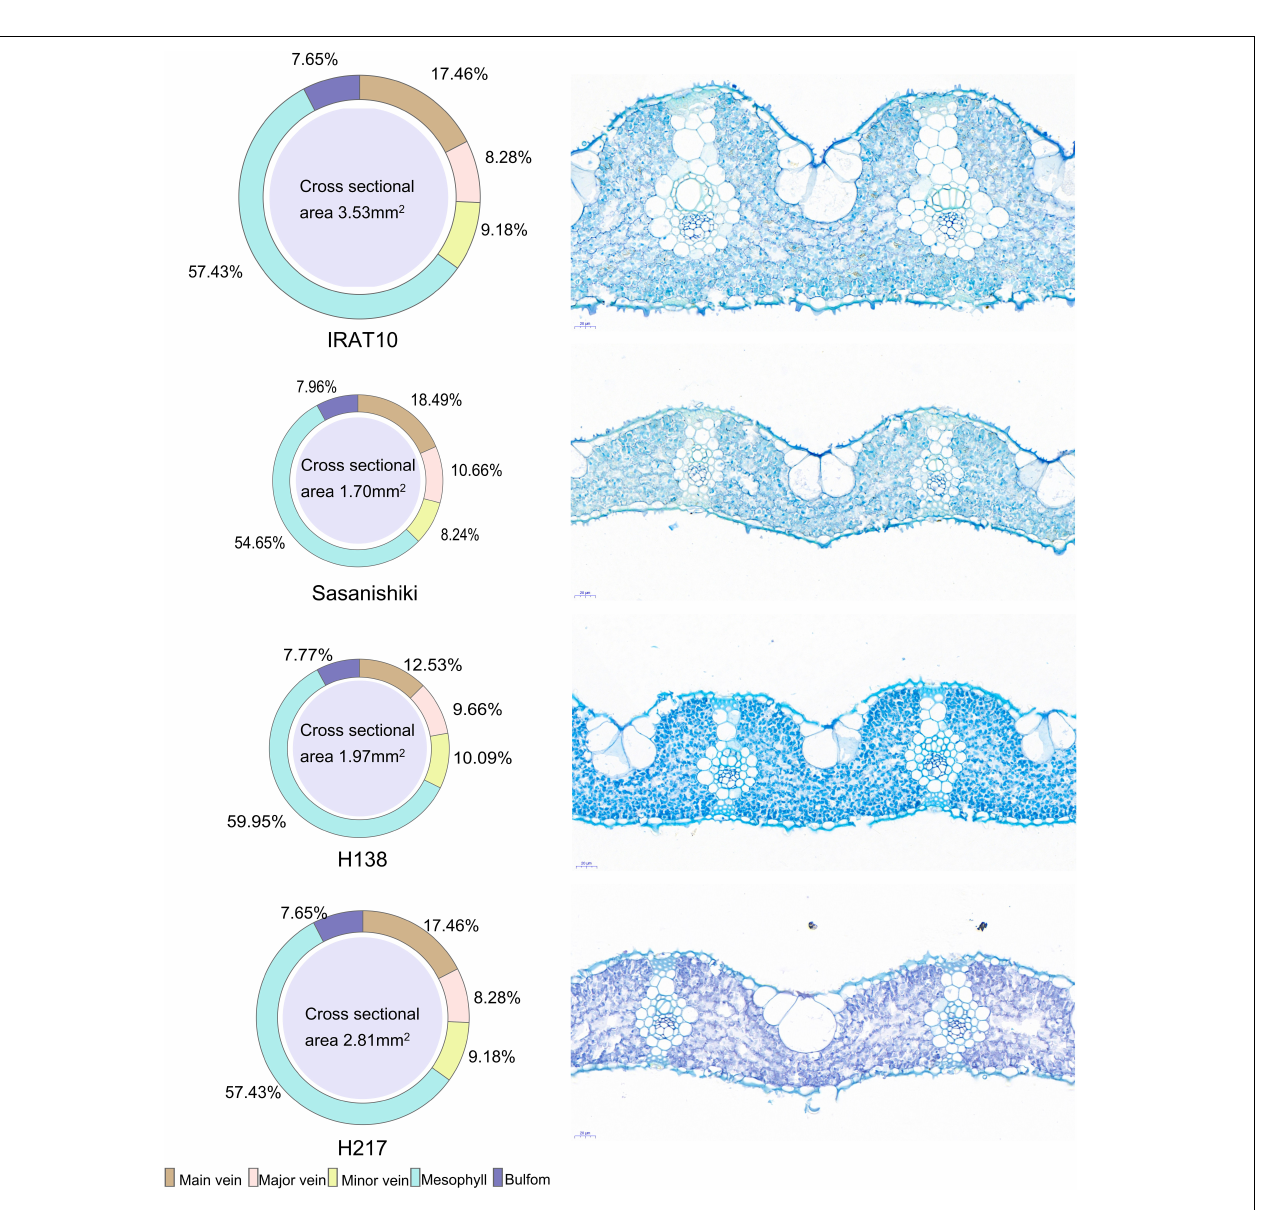
FIGURE 1 | The phenotype of flag leaves of tested varieties. The cross-sectional area of the flag leaf and the proportion of each tissue are shown on the left . Slice images are shown on the right .